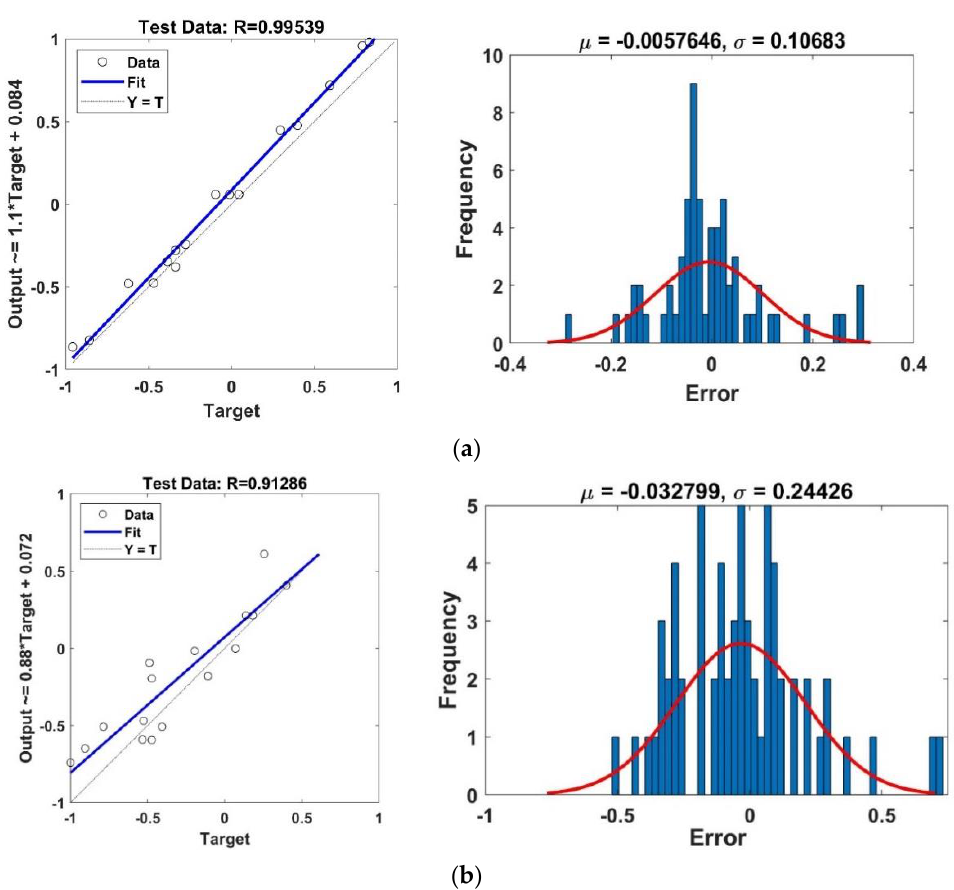
Figure 12. KNN results for estimating static properties: ( a ) for UCS and ( b ) for EM.